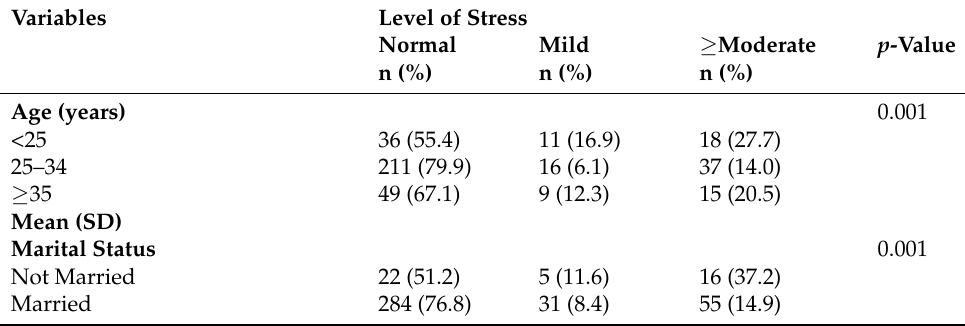
Table 5. Associations between the respondents’ characteristics and